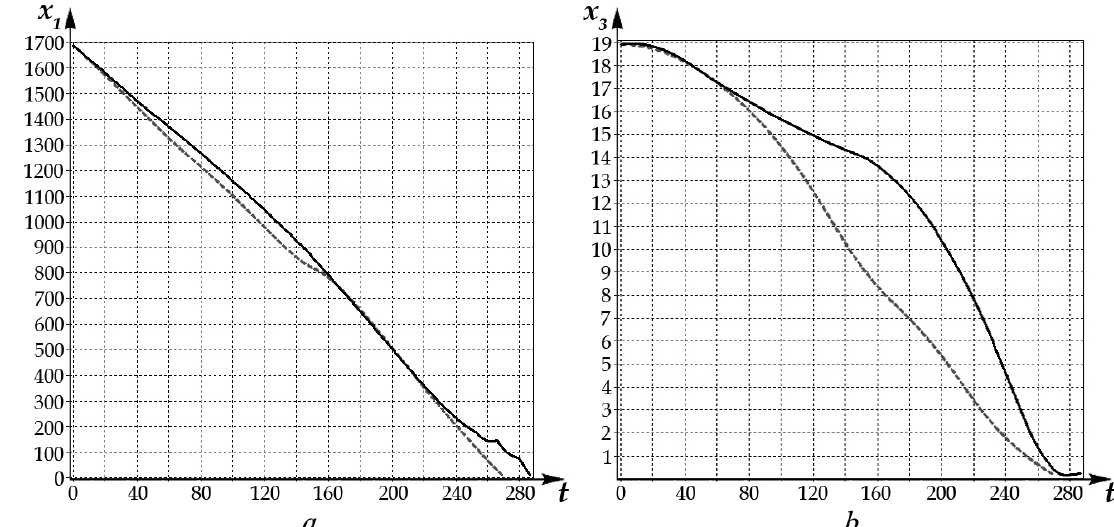
Figure 3. The graphs of trajectories: ( a ) spacecraft speed over time x 1 ( t ) ; ( b ) spacecraft altitude over time x 3 ( t ) . Found solution—black solid line; reference solution—grey dashed line.